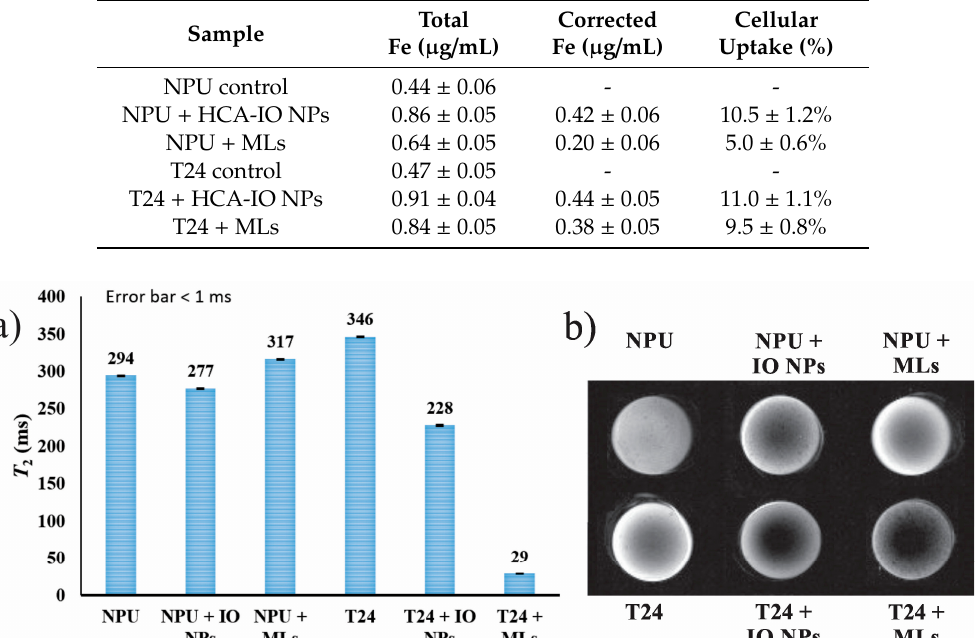
Table 4. After 24 h incubation of normal (NPU) and cancerous T24 cells, Fe content in the cells was determined using ICP-MS analysis. For the calculation of cellular uptake, the endogenous Fe (control groups) was subtracted (marked as Corrected Fe).